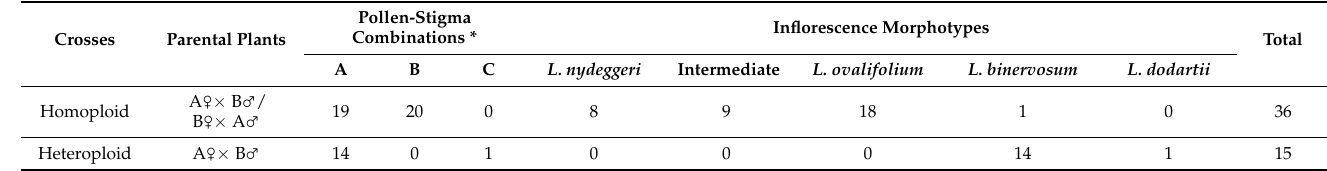
Table 1. Pollen-stigma combinations and inflorescence phenotypes of investigated plants. These plants were pro- duced in homoploid (diploid × diploid) and heteroploid (tetraploid × diploid) experimental crosses carried out in [4]. * Pollen-stigma combinations followed [7]: A: coarsely reticulate exine (A pollen)/ cob -like stigma; B: finely reticulate exine (B pollen)/papillate stigma; and C: coarsely reticulate exine (A pollen)/papillate stigma. A and B represent self-incompatible combinations (self-sterile) and C is a self-compatible (self-fertile) combination. No individuals with the self-compatible combination D (microreticulate pollen/ cob -like stigma) were reported. The intermediate inflorescence morphotype combines characteristics of scapes from both Limonium ovalifolium and L. nydeggeri . Symbols: —female recipient; —male donor. ♀ ♂ Pollen-Stigma Combinations * Crosses Parental Plants